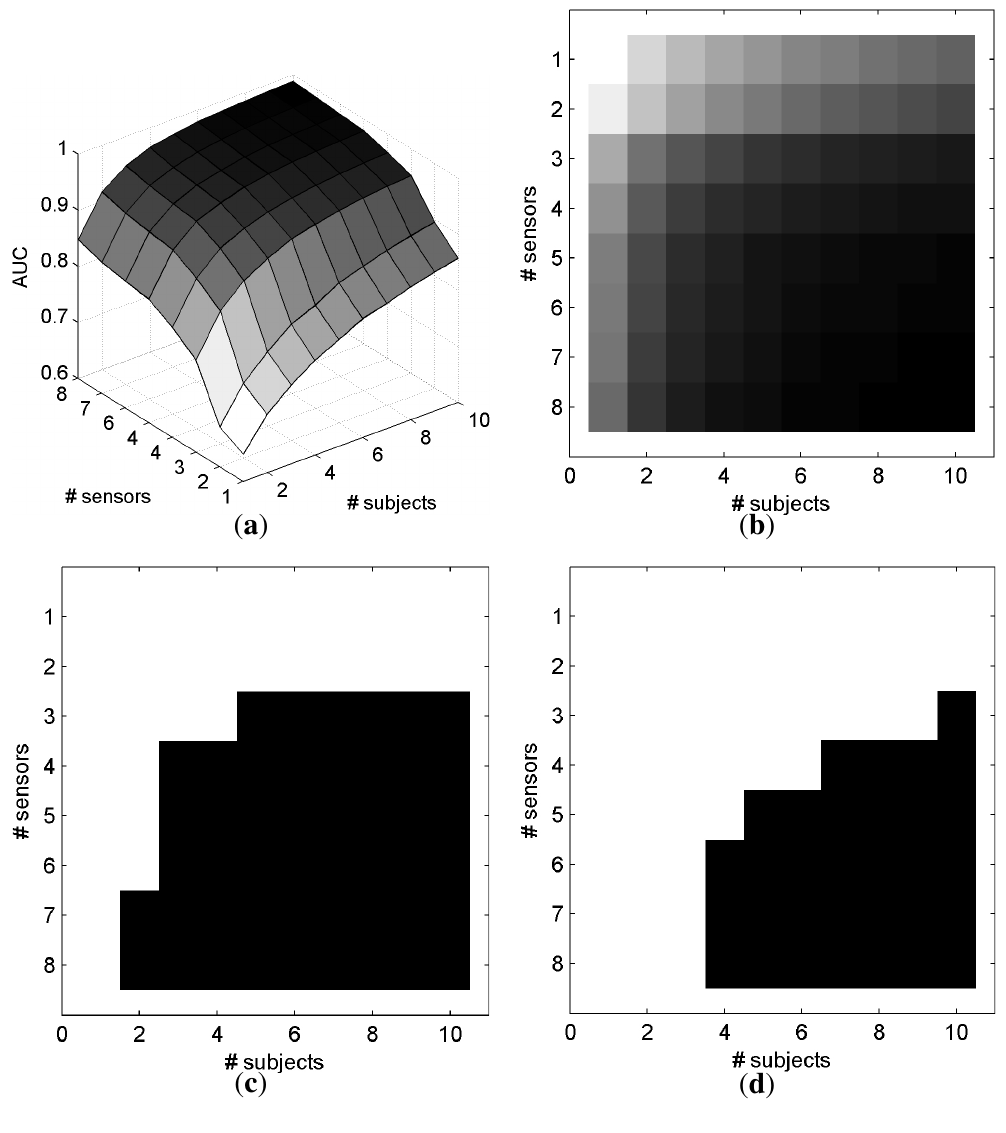
Figure 7. AUC based on the number of electrodes and subjects with the SS common method for electrode selection and O for fusing the classifier outputs across subjects. sum ( a ) 3D representation of the AUC; ( b ) 2D representation of the AUC; ( c ) AUC > 0 . 90 ; ( d ) AUC > 0 . 95 . (In Figure 7b, a dark gray level represents a high